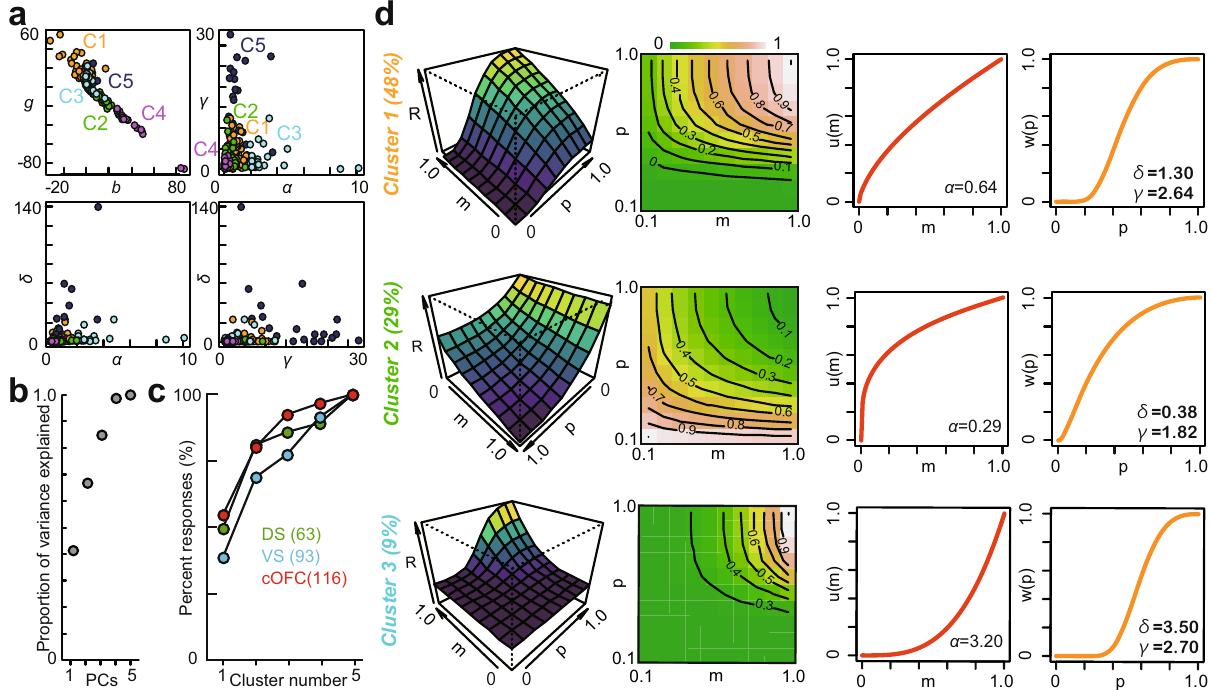
Fig.5|Neuronalclusterscategorizedbythe fi ttedparametersaccordingtothe prospect theory model. a Plots of all fi ve parameters estimated in DS, VS, and cOFCneurons. g , b , α , δ ,and γ wereplotted. b Cumulativeplotoftheproportionof variance explained by PCA is shown against principal components PC1 –